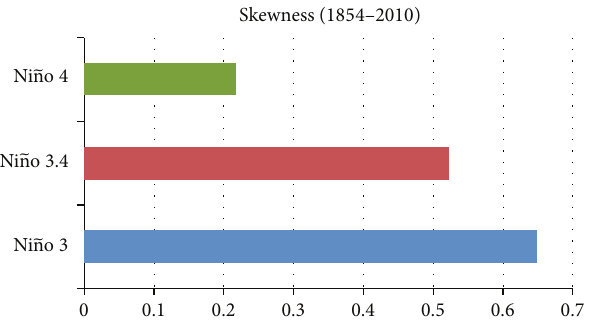
Figure 10: Skewness of November ENSO indices of ERSST observation for the period from 1854 to 2010.